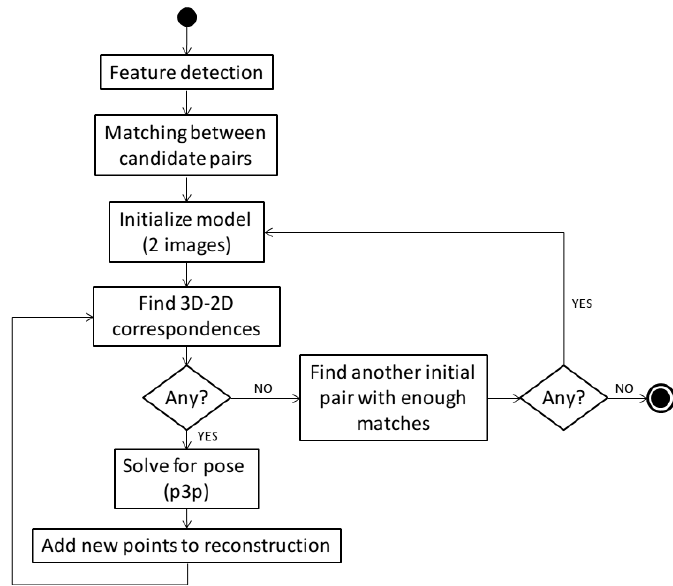
Figure 3. Flux diagram of the Structure-from-Motion pipeline used to construct the initial up-to-scale 3D models from optical data only. After feature detection and matching, a 2-view model is used to initialize the structure, which is then progressively updated by adding new cameras and 3D points using 3D-2D matching and